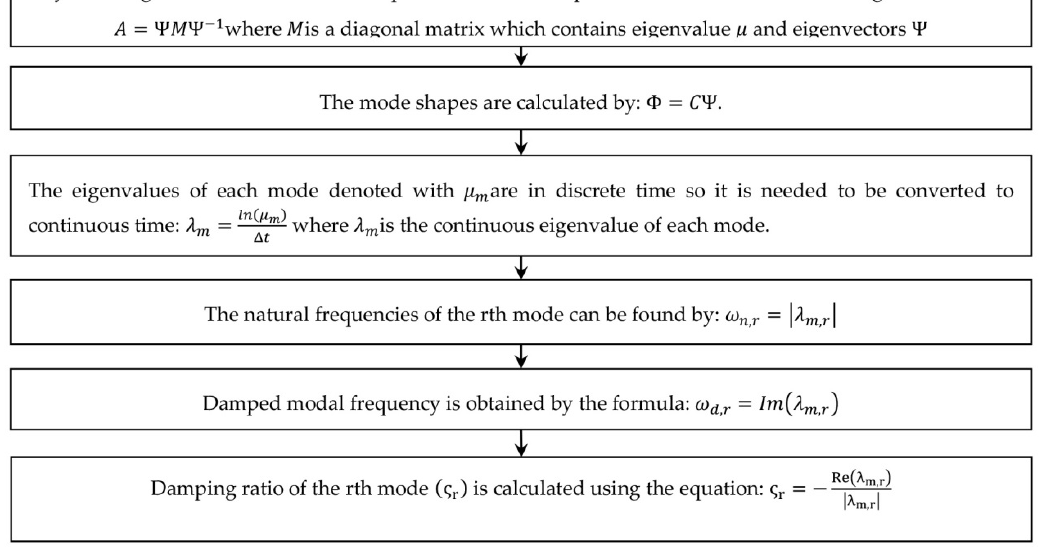
Figure 3. Methodology of the calculating modal parameters from the state-space parameters of subspace system identification algorithm.